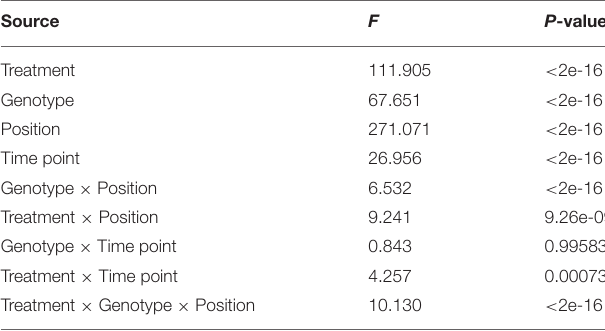
TABLE 1 | Results of ANOVA: genotype and position effects on Populus euphratica leaf length.